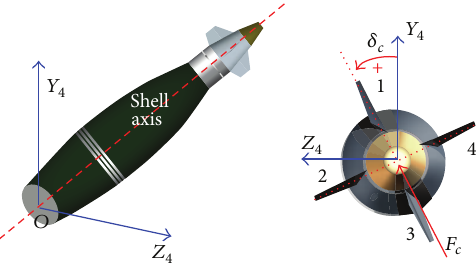
Figure 11: Phase angle definition (from